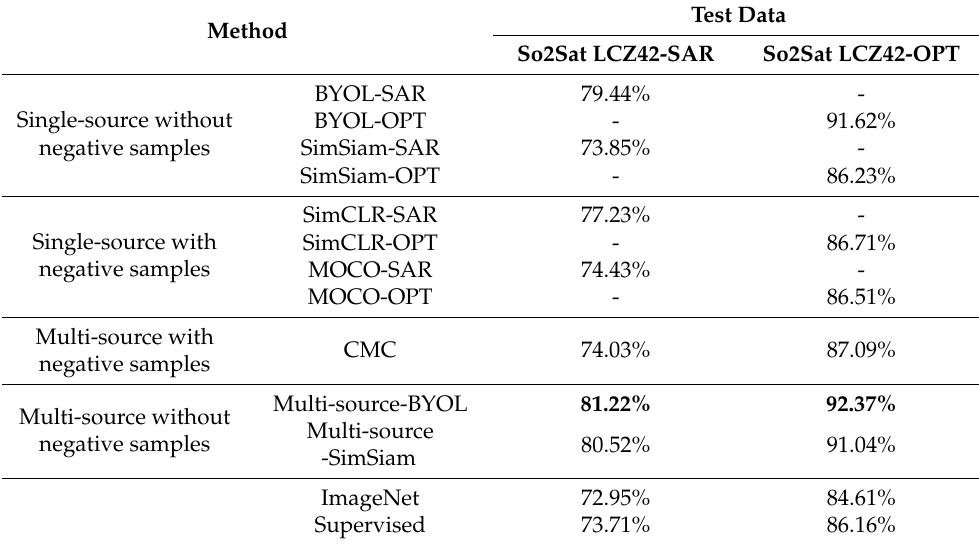
Table 1. Overall accuracy (%) obtained by different methods on the test set with a linear